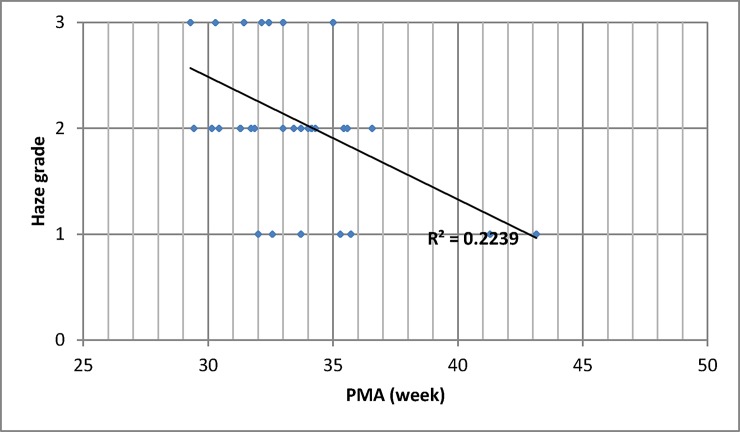
Corneal haze grades and post-menstrual age.Grade 0 = clear; Grade 1 = delayed haze (Corneal haze not noted immediately after opening the eye, but noted later in the examination); Grade 2 = mild/moderate haze (Corneal haze noted immediately after opening the eye, but it did not hinder retinal examination); Grade 3 = severe haze (Corneal haze noted immediately after opening the eye and it interfered with retinal examination). PMA: postmenstrual age. *The severity of corneal haze decreased with infants’ PMA (p = 0.014).